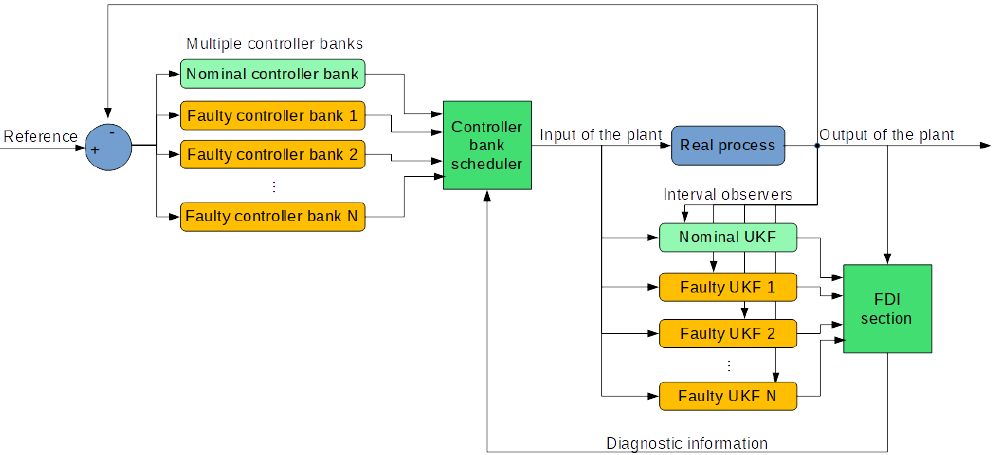
Figure 8. FTC strategy using two-layer, multiple-model